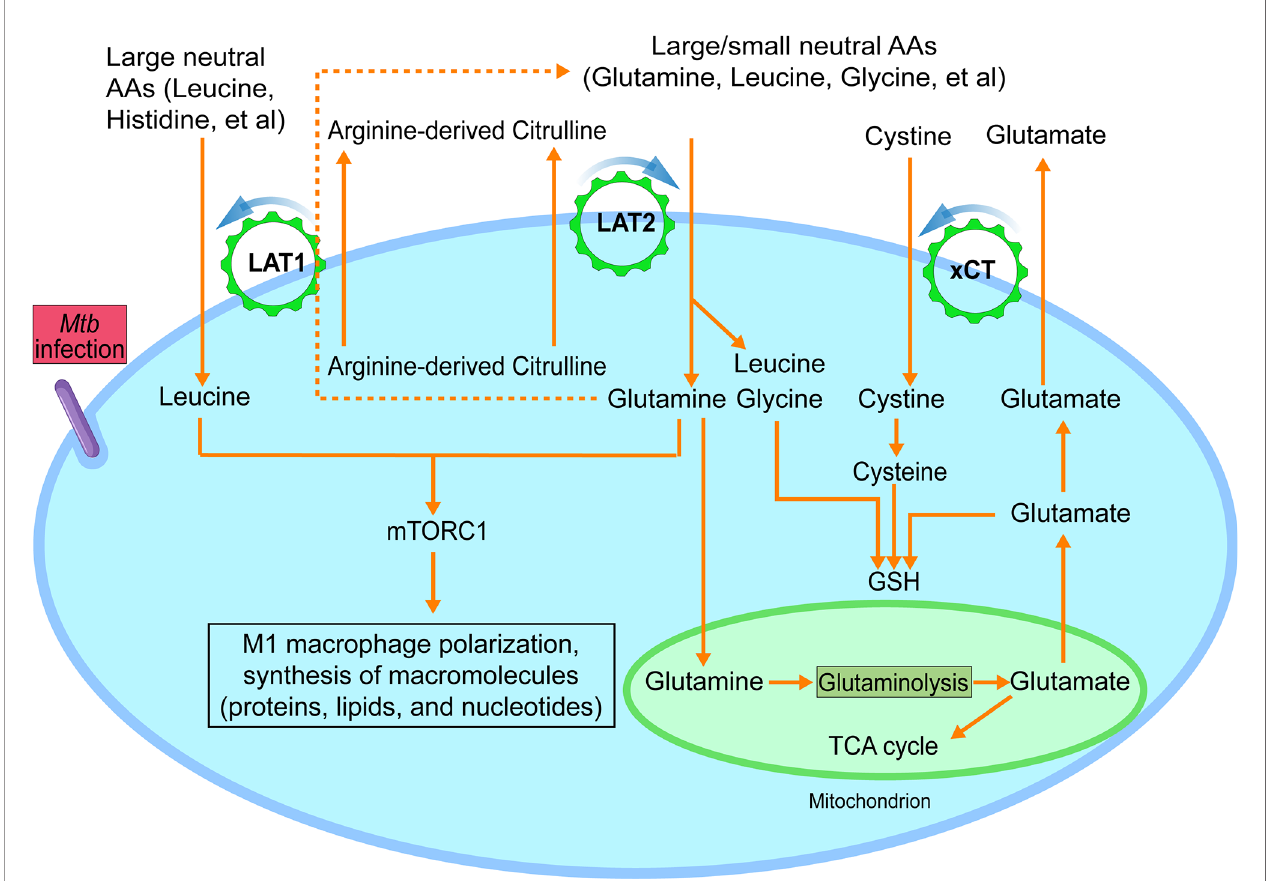
FIGURE 2 | Functional model of LAT1, LAT2 and xCT amino acid transporters during M1-like polarization. During M1-like polarization, increased need for amino acids, including essential ones, is met by upregulated amino acid transporters LAT1, LAT2 and xCT. LAT1 and LAT2-mediated uptake of neutral amino acids from the extracellular environment requires an intracellularly accumulated neutral amino acid as export substrate to activate the exchange process with a 1:1 stoichiometric ratio. And such intracellular metabolite could be citrulline, which is abundantly produced by the highly upregulated NOS2 and actively secreted by M1-like macrophages. The uptake of neutral amino acids, such as leucine and glutamine, drives the activation of mTORC1, which is critical for multiple processes of M1-like polarization, including synthesis of macromolecules. Alternatively, the apparent differential af fi nities of LAT1 and LAT2 with certain neutral amino acid substrates also suggest a potential functional cooperation between the two LAT transporters in which LAT2-mediated accumulation of intracellular glutamine could serve as an export substrate of LAT1 (dashed line), as seen in cancer cells, to drive the uptake of essential neutral amino acids for which LAT1 has high af fi nity, such as histidine. The uptake of cystine by xCT, activated by increased production of glutamate from mitochondrial glutaminolysis with increased GLS (glutaminase) and the reduction of intracellular cystine to cysteine, participates in glutathione (GSH) synthesis, contributing to the redox homeostasis of M1-like macrophages. Findings from recent report that arginine metabolism-mediated glycolysis and mTOR activation are required for Mtb control in the absence of NO support the additional role of arginine metabolism, as reported in (44). AA, amino acids. Data were derived from references and/or supplementary fi les therein (27 –